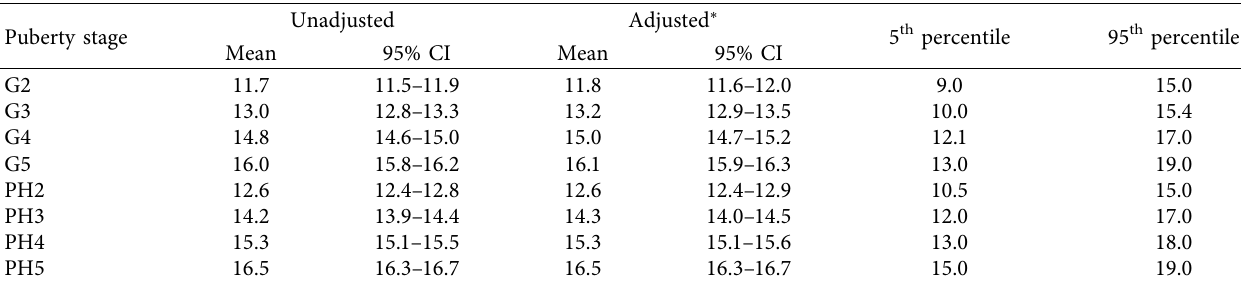
Table 2: Unadjusted and adjusted mean age by the puberty stage in our study. Puberty stage